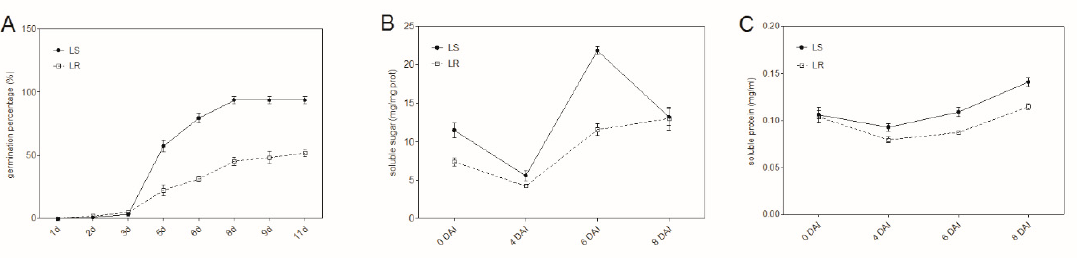
Figure 1. Seed germination characters in a Polypogon fugax accession susceptible to aryloxyphenoxypropionate (APP) herbicides (LS and a P. fugax accession resistant to APP herbicides (LS). ( A ) Dynamic change of germination percentage of LS and LR seeds; dynamics change of soluble sugar ( B ) and soluble protein content ( C ) of LS and LR seeds. The solid line represents LS and the dotted line represents LR. DAI means days after incubated. Bars are mean ± standard error (n = 5).